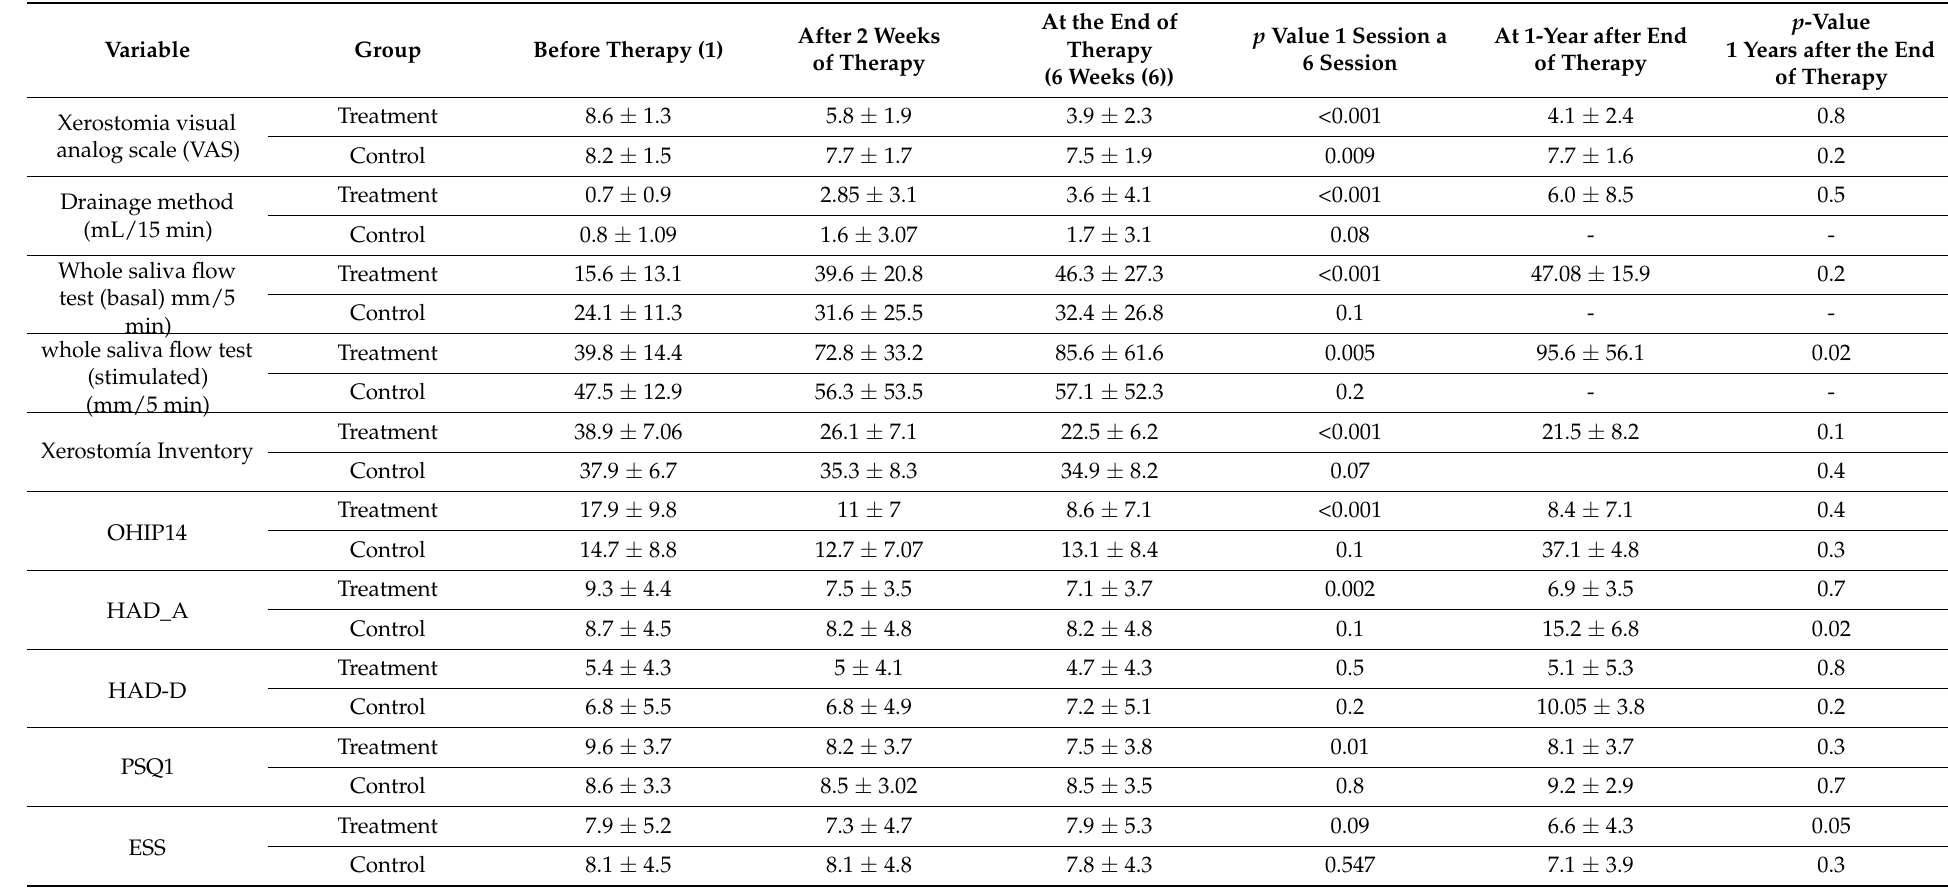
Table 1. Efficacy of photobiomodulation (PBM) applied over 6 consecutive weeks. with one session per week. (Treatment group and control